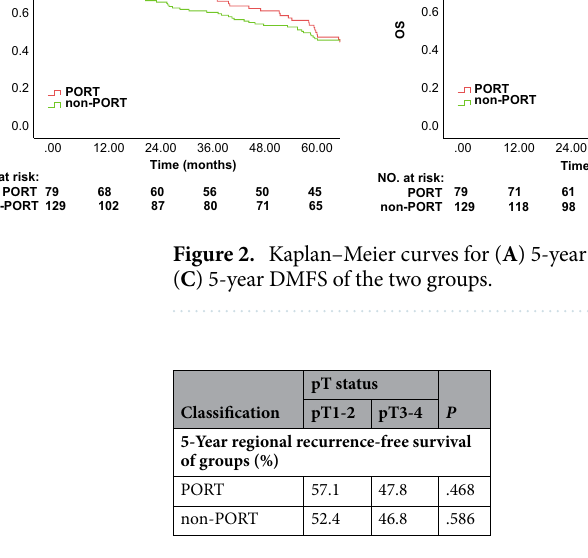
Table 3. Survival comparison. RRFS regional recurrence-free survival, pT status pathologic tumor status.